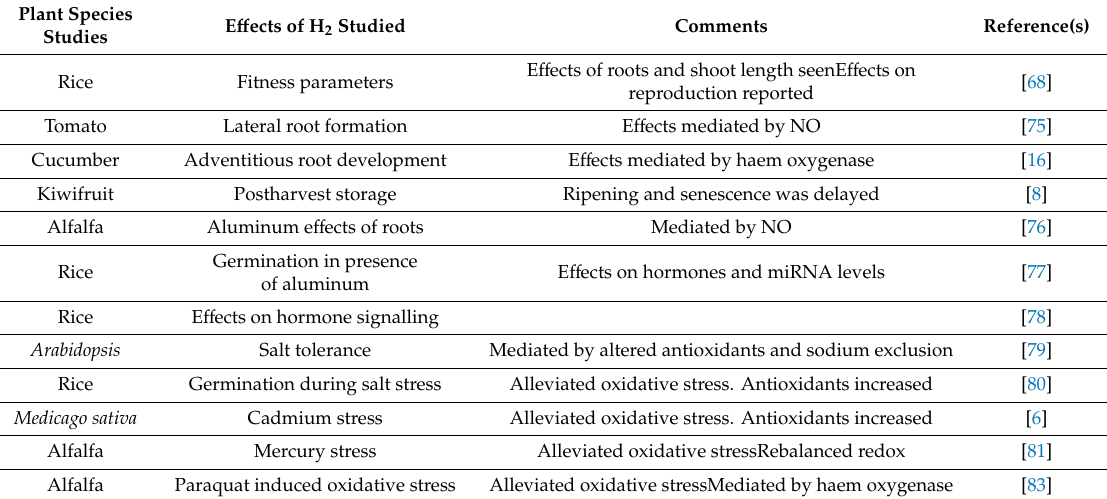
Table 2. A summary of some of the e ff ects of molecular hydrogen in